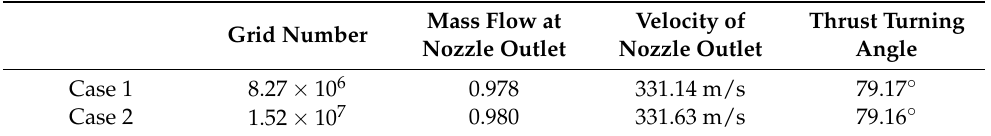
Table 2. Data from the grid independence check.